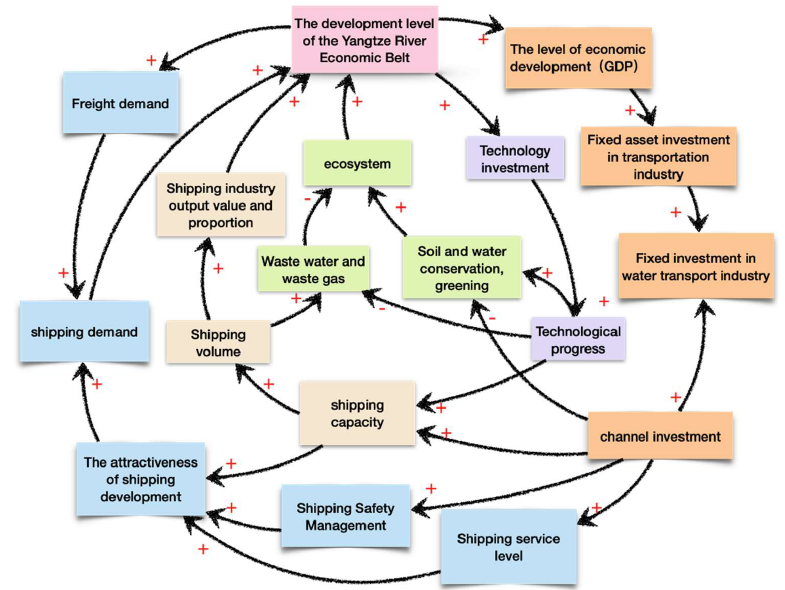
Figure 2. The network relationship diagram of the interactive development of the Yangtze River waterway and the Yangtze River Economic Belt. (+ positive influence; − negative influence)